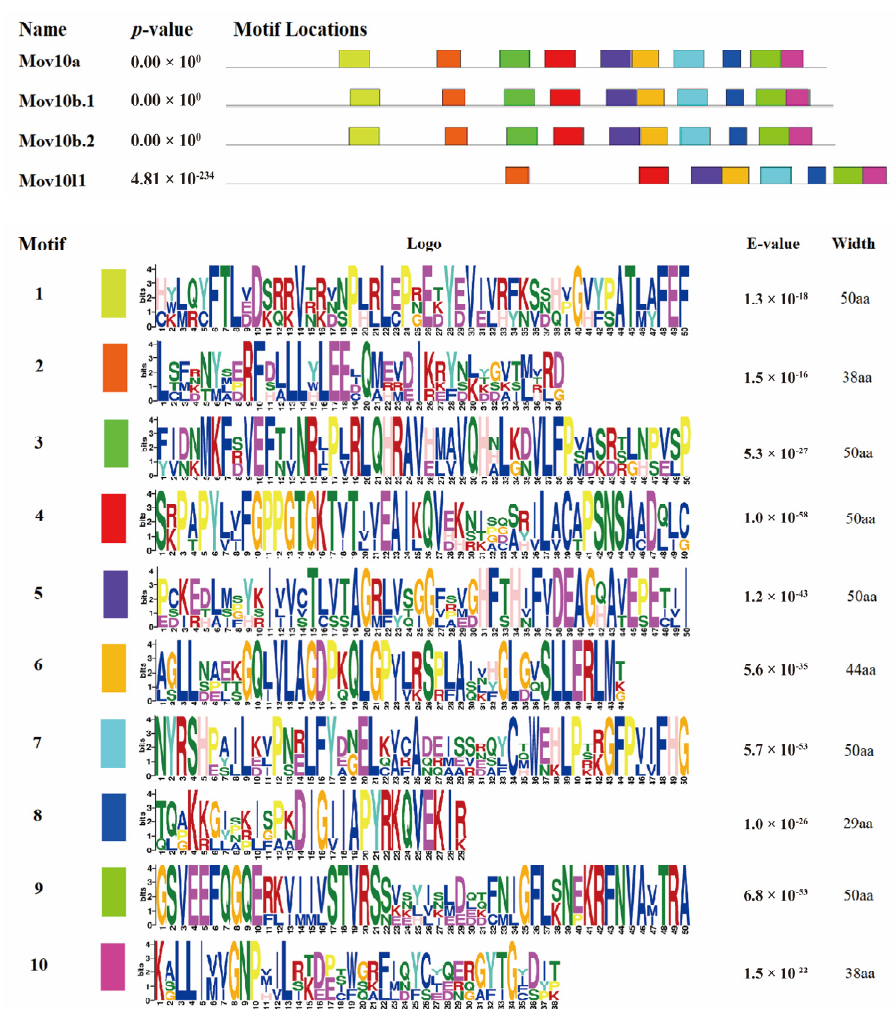
Figure 7. The schematic diagram of motifs of zebrafish Mov10s and Mov10l1 proteins. The motifs are arranged according to the position on the protein sequence, the letters in each motif are amino abbreviation. The size of the letter represents the saliency of the amino acid in the motif. The larger the letter, the higher the saliency, which is, the higher the frequency at which the amino acid appears in the same position in the same motif in different sequences.